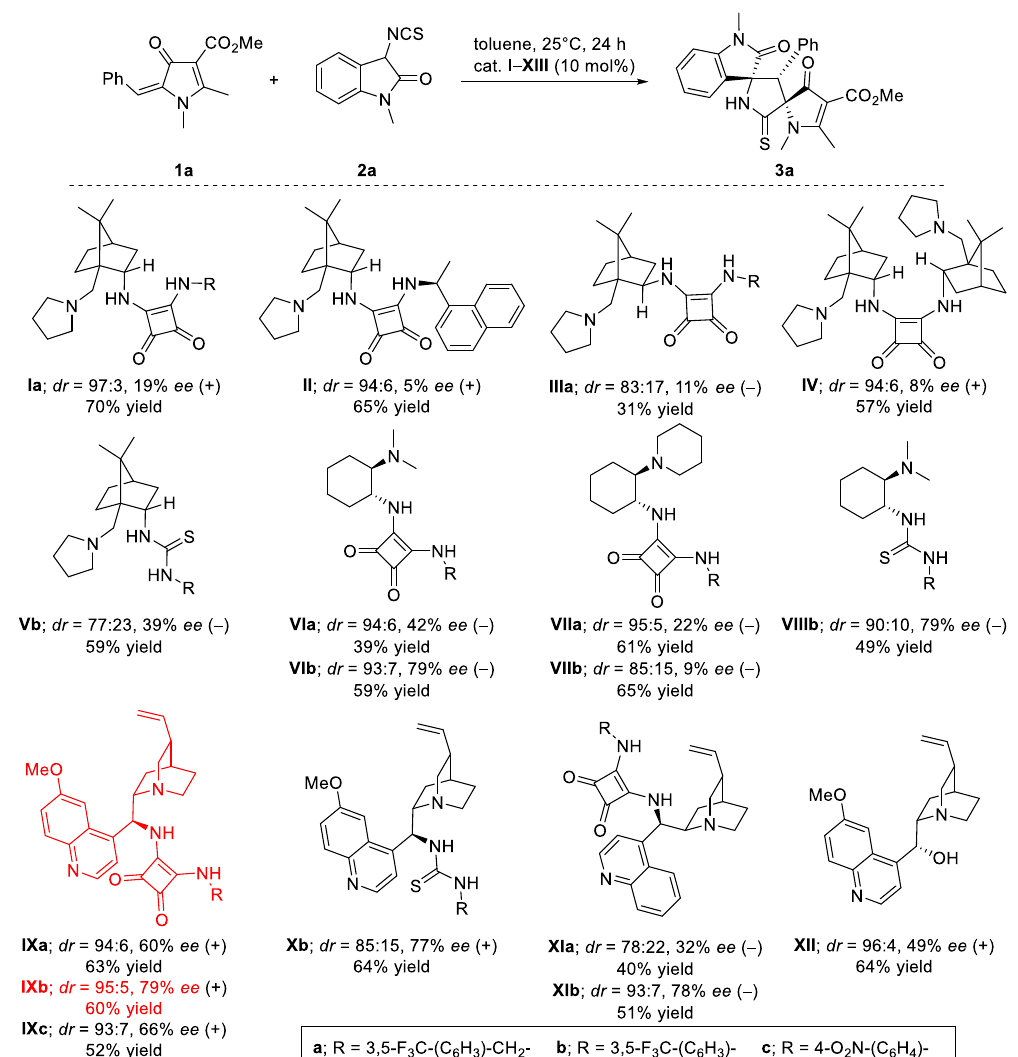
Scheme 2. Evaluation of organocatalysts I-XII in a model reaction 1a + 2a → 3a Table 1. Evaluation of organocatalyst IXb in bis-spiroheterocyclization of 5-arylidene-Δ 2 -pyrrolin-4- one 1a with 3-isothiocyanatooxindole 2a. a